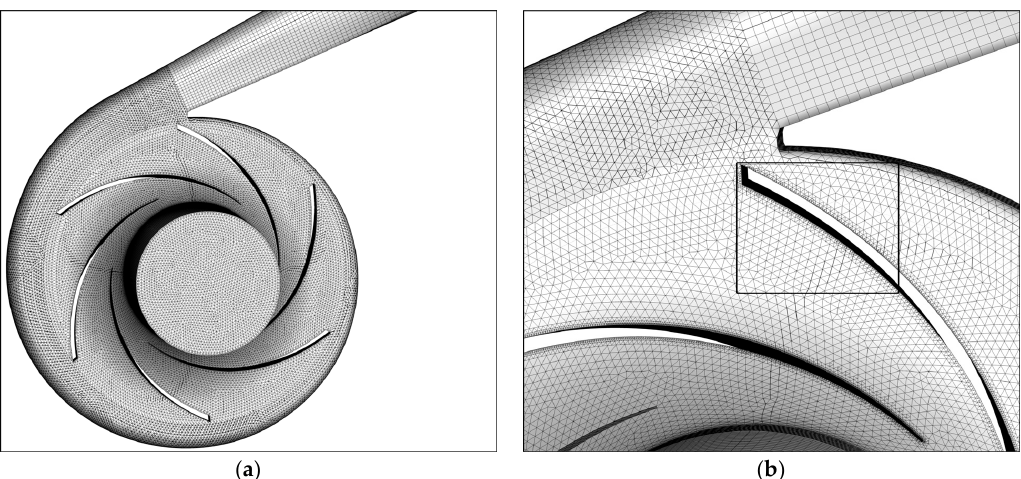
Figure 2. Computational geometry of the centrifugal pump for each part.